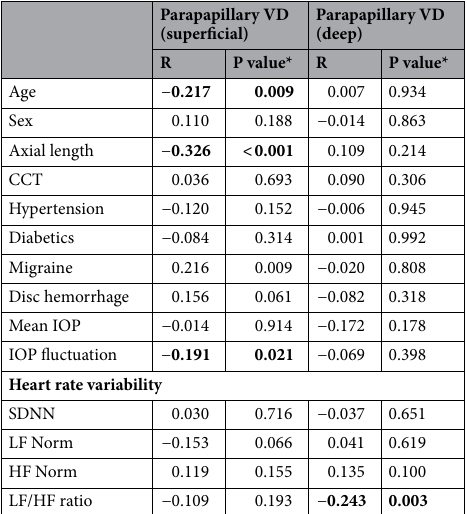
Table 4. Correlation coefficients for parapapillary vessel density(VD) with ocular parameters and heart rate variability in total subjects. VD = Vessel density; IOP = intraocular pressure; SDNN = Standard deviation of NN-interval; LF = Low frequency ; HF = High frequency ; R = correlation coeffcient. *Pearson correlation analysis.